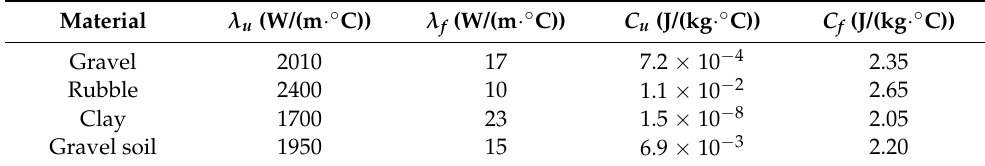
Table 2. Thermal parameters in the permafrost subgrade model.